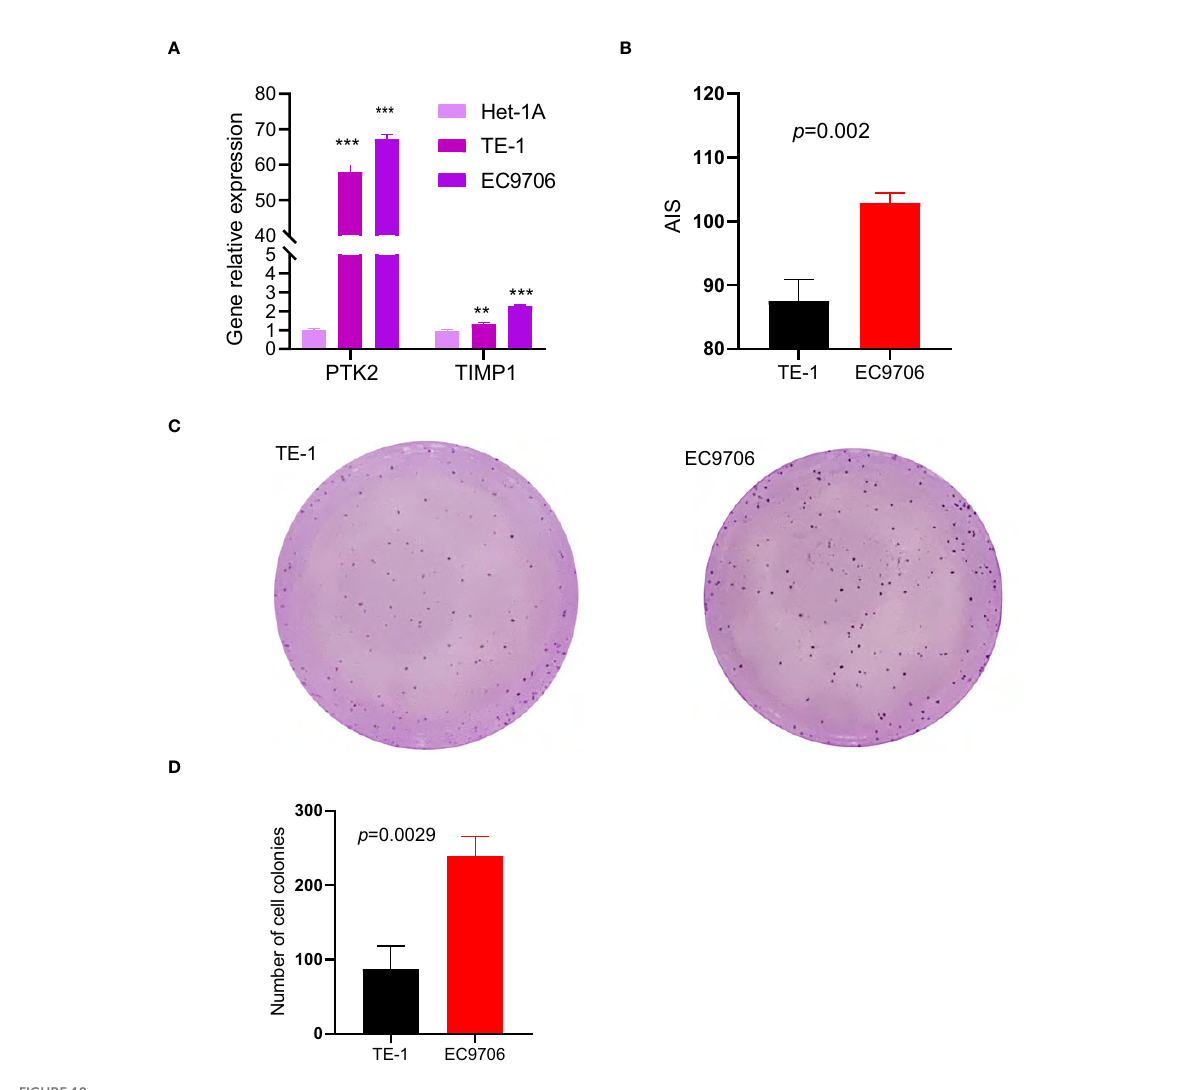
FIGURE 10 ESCC cell line experiments validate the predictive value of the two-gene signature in vitro, (p values were showed as: **p < 0.01; ***p < 0.001). (A) Expression levels of PTK2 and TIMP1 in two cancer cell lines and one normal cell line. (B) AIS of the two different risk cell lines calculated based on RT-qPCR results. (C, D) Plot of colony formation for two cancer cell